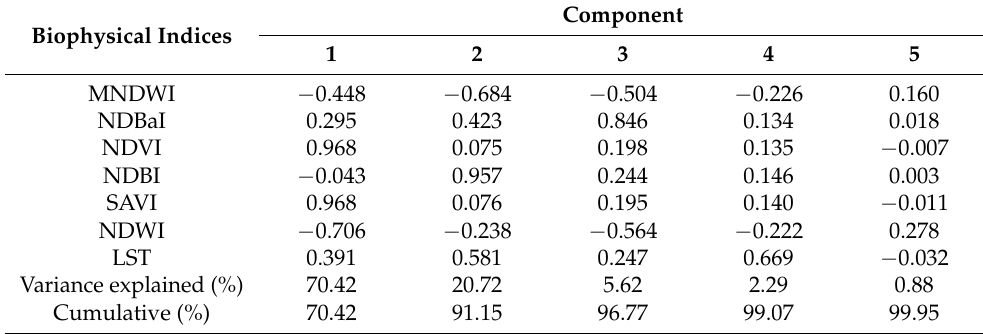
Table 5. PCA analysis of